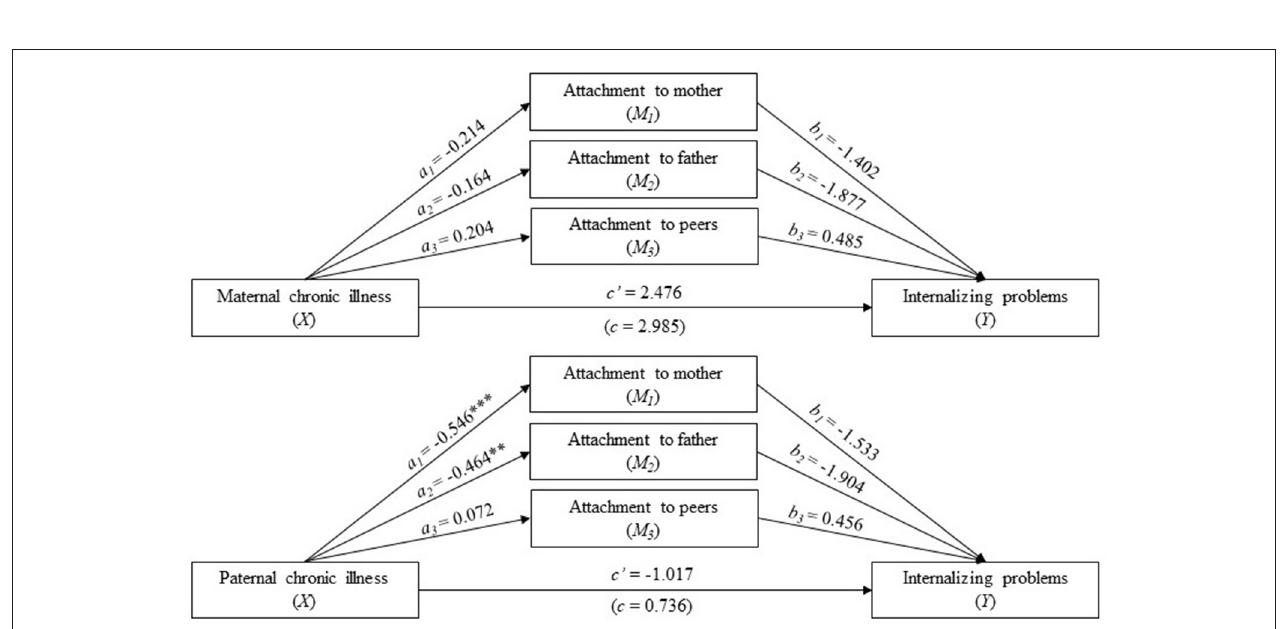
FIGURE 4 | Separate analyses for adolescent males. Parallel mediation analysis with parental (maternal above and paternal below) chronic illness status (0 is no and 1 is yes) as the independent variable (X), internalizing problems in young adulthood with a high score indicates high levels of problems (Y), and attachment to the mother, father, and peers as the mediators (a high score indicates secure attachment). The values are unstandardized regression coefficients. a n is the effect of parental chronic illness in adolescence on attachment to the mother, father, and peers; b n is the effect of attachment to the mother, father, and peers on internalizing problems in young adulthood. The black lines indicate no statically significant paths. The analysis was adjusted for adolescent sex and parental SES and divorce. * p < 0.05, ** p < 0.01, *** p < 0.001.